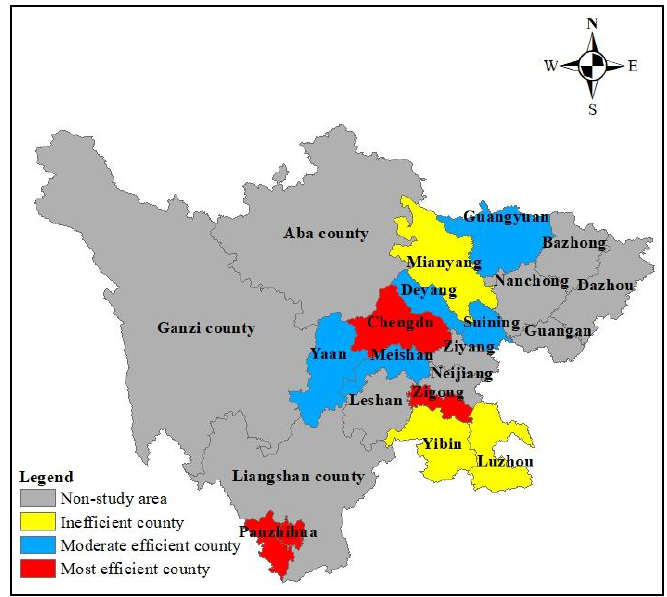
Figure 7. CGLUE in 11 counties of Sichuan Province.